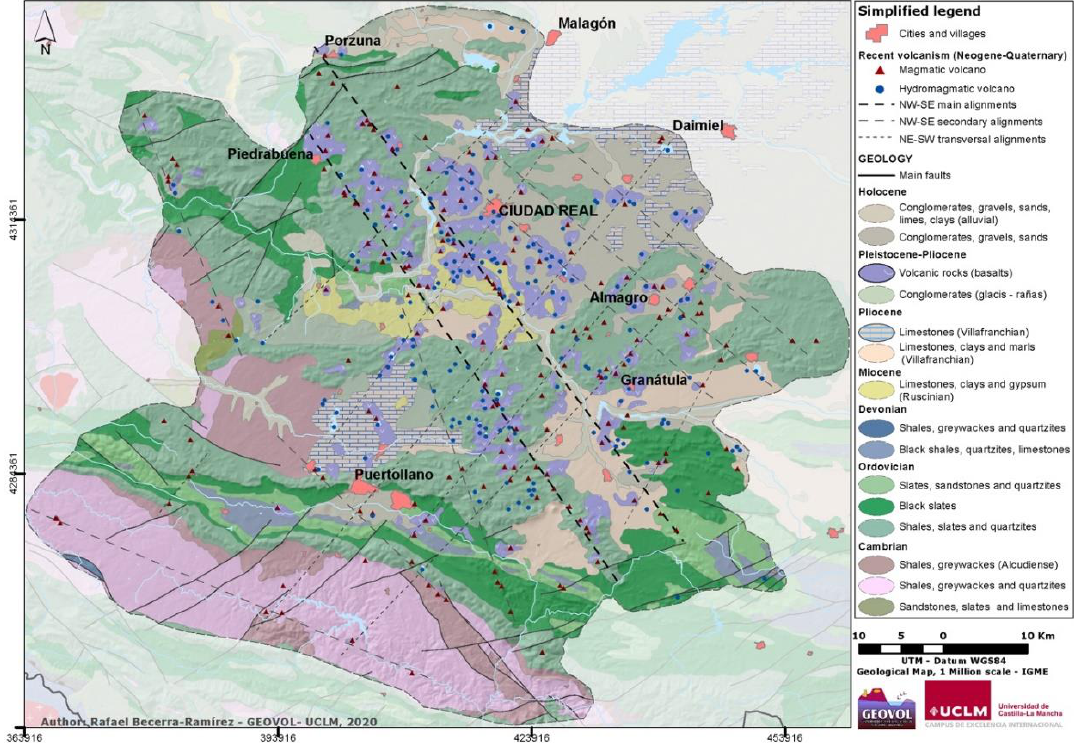
Figure 2. Geological map (1 million scale, IGME) [47], distribution of volcanoes and main volcanic alignments [9,11,12,21,29].